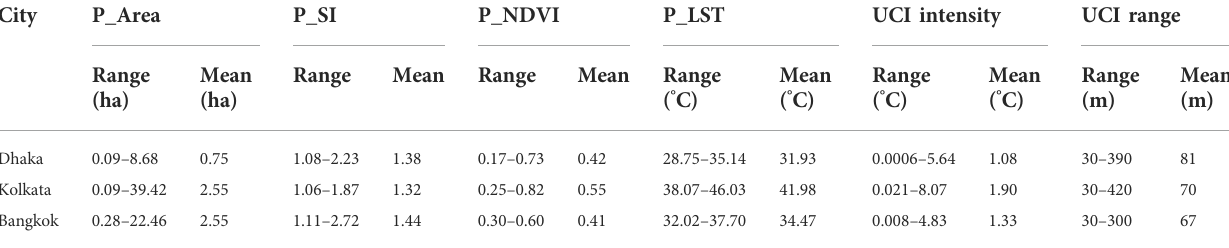
TABLE 5 Statistics of landscape metrics, UCI intensity and range in the three megacities.